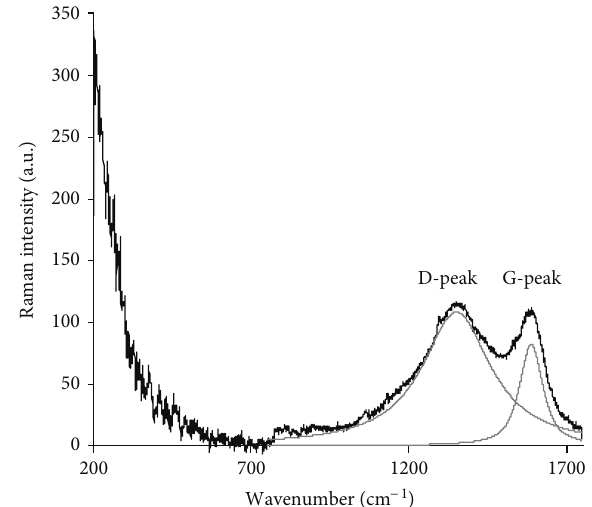
Wavenumber (cm −1 F 2: Micro-Raman spectrum of polyethylene treated by PIII ions/cm �uence. e with nitrogen ions of 20keV energy and 10 spectrum is �tted with mixed �orentz�Gauss functions at 1350 and 16 2